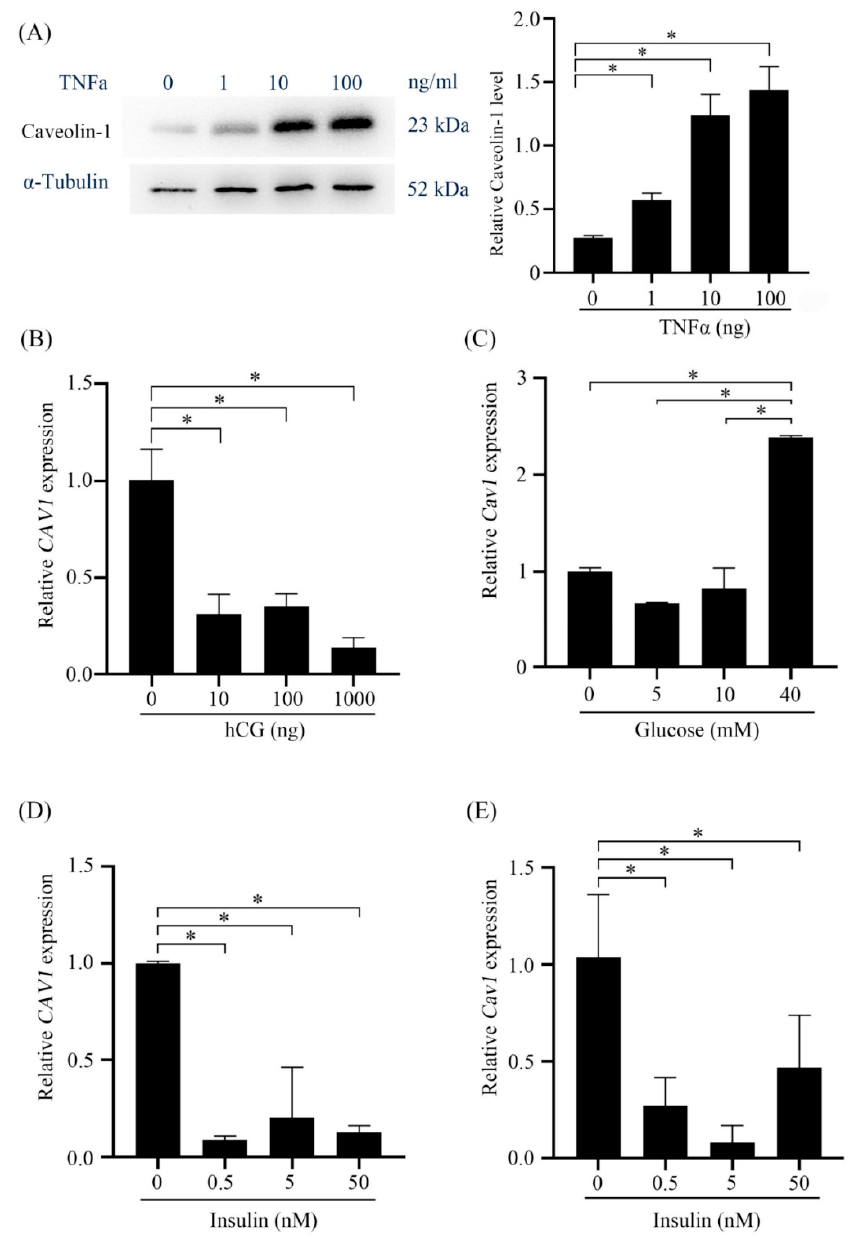
Figure 10. Regulation of Caveolin-1 by TNF α , hCG, high glucose, and insulin. ( A ) Western blots analysis of Caveolin-1 protein levels in mouse uterine stromal cells treated with TNF α for 30 min. ( B ) The levels of Caveolin-1 after human stromal cells were treated with hCG for 12 h. ( C ) The levels of Caveolin-1 in mouse stromal cells treated with glucose for 3 days. ( D ) The levels of Caveolin-1 in human stromal cells treated with insulin for 6 h. ( E ) The levels of Caveolin-1 in mouse stromal cells treated with insulin for 12 h. *, p < 0.05.